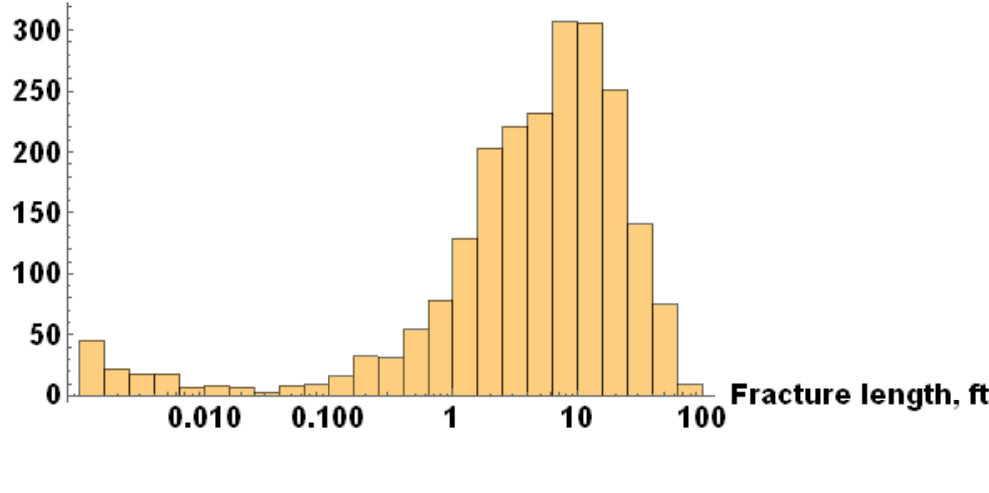
Figure 16—Histogram of the fracture length in Case